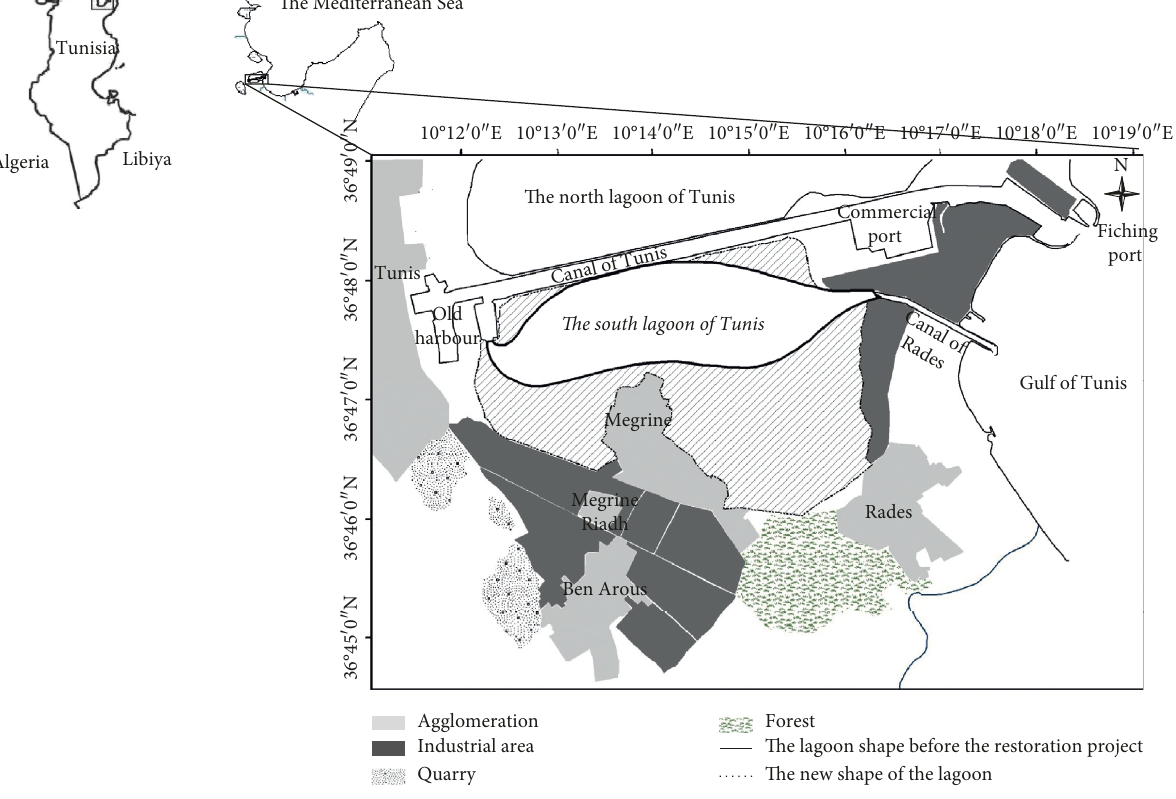
Figure 1: Map showing the study area.